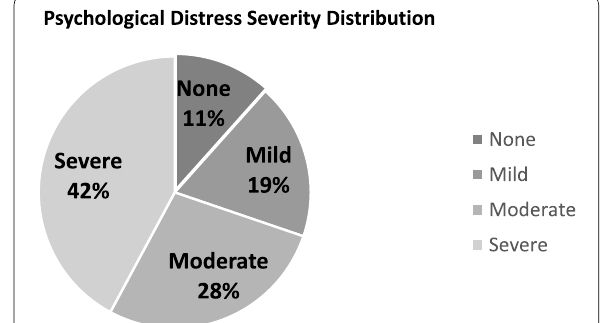
Fig. 1 Psychological distress severity on PHQ‑4 scale among medical students in Jordan ( n 2104) =